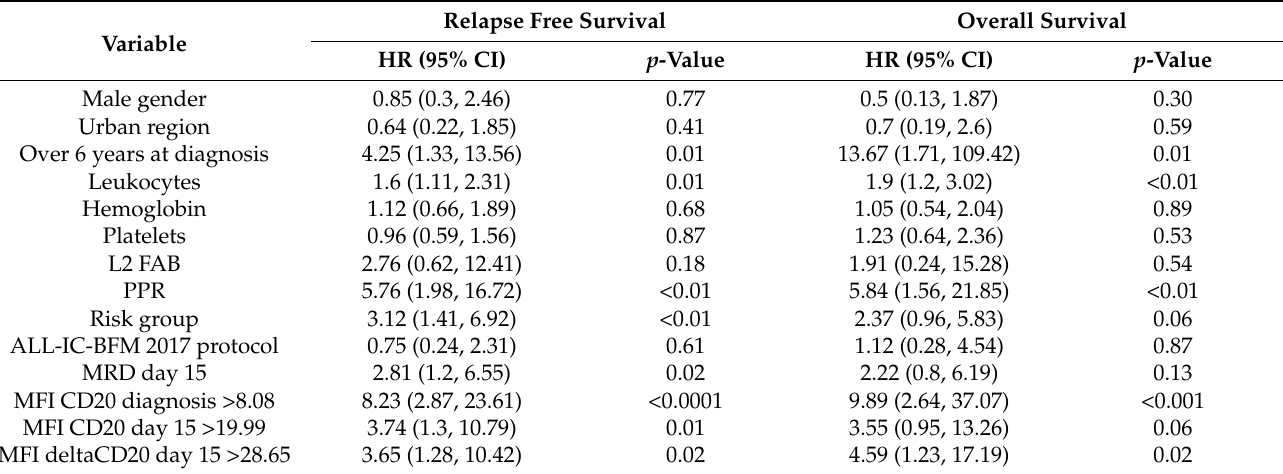
Table 2. Variables associated with RFS and OS.